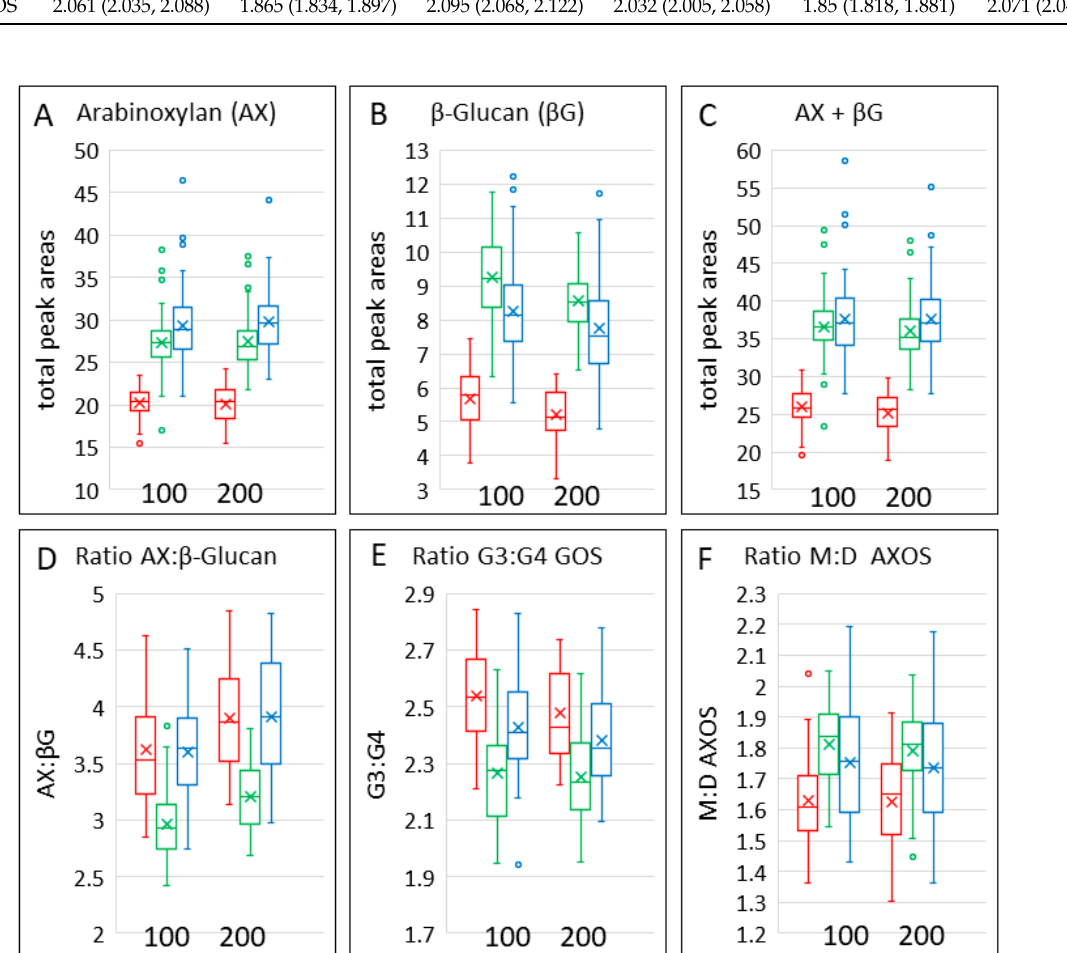
Figure 5. Contents, ratios and structures of arabinoxylan and β -glucan in grains of the three cereal types grown in four environments. Colour code: red, emmer; green, spelt; blue, bread wheat. The box shows the middle two quartiles, separated by the horizontal line, which is the median, and the vertical lines are the upper and lower quartiles, respectively. Outliers are shown as circles. The x is the mean